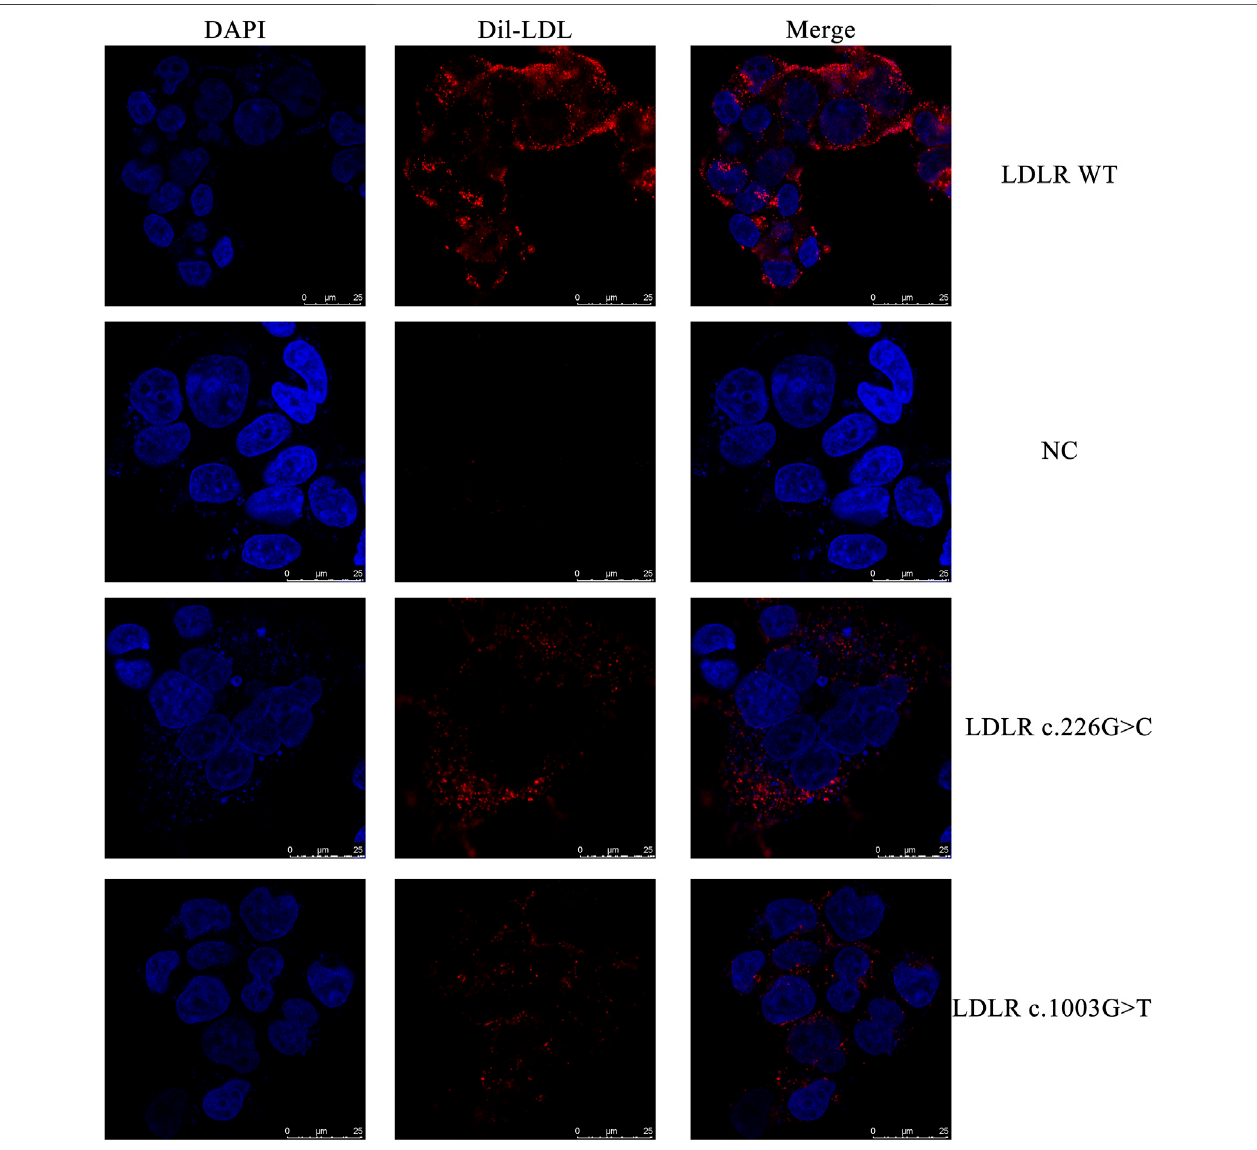
FIGURE 4 | The representative confocal microscopy images. Blue fl uorescence represented DAPI, while red fl uorescence represented Dil-LDL.